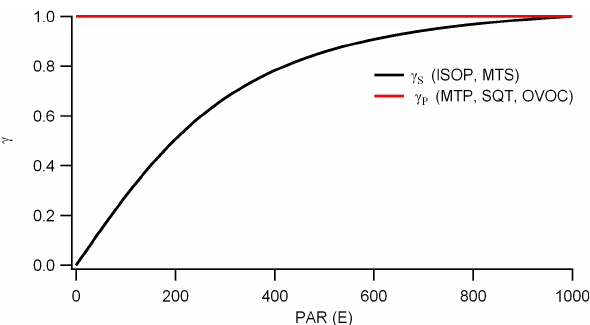
Fig. 2. Dependence of the environmental correction factors γ P and Fig. 2 : Dependence of the environmental correction factors γ P and γ S on PAR at T=30 ◦ . γ S on PAR at T = 30 ◦ .